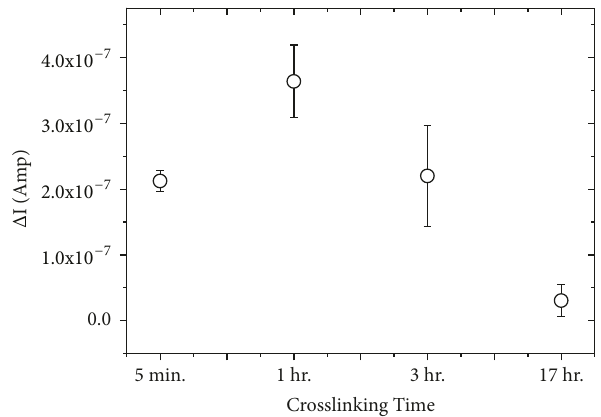
Figure 6: The difference in CV baseline current between two temperatures,25 ∘ C and 50 ∘ C, in 0.5MSPB, as a functionof BMDPM crosslinking time. Δ𝐼 on the 𝑦 -axis is the temperature-induced change in the baseline separation between forward and reverse CV sweeps, Δ𝐼 = (𝐼 𝐹𝑜𝑟𝑤𝑎𝑟𝑑 – 𝐼 𝑅𝑒 V 𝑒𝑟𝑠𝑒 ) 25 C − (𝐼 𝐹𝑜𝑟𝑤𝑎𝑟𝑑 – 𝐼 𝑅𝑒 V 𝑒𝑟𝑠𝑒 ) 50 C , measured at a bias of 0.1